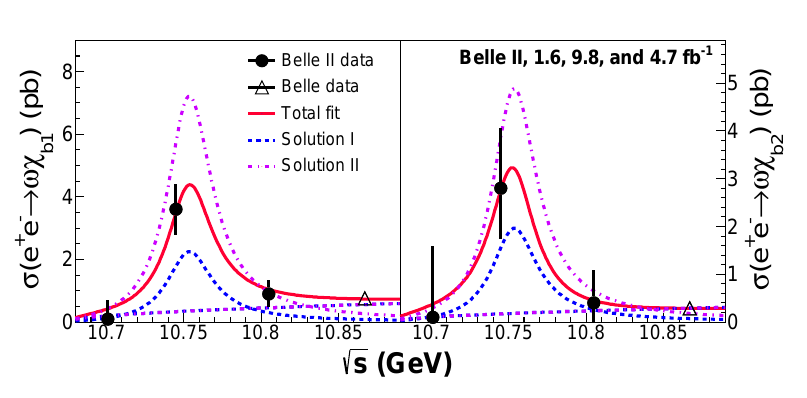
Figure 6. Energy dependence of the cross sections for e + e − → ωχ b 1 (left panel) and e + e − → ωχ b 2 (right panel) [32]. Curves show the fit results and various components of the fit function.